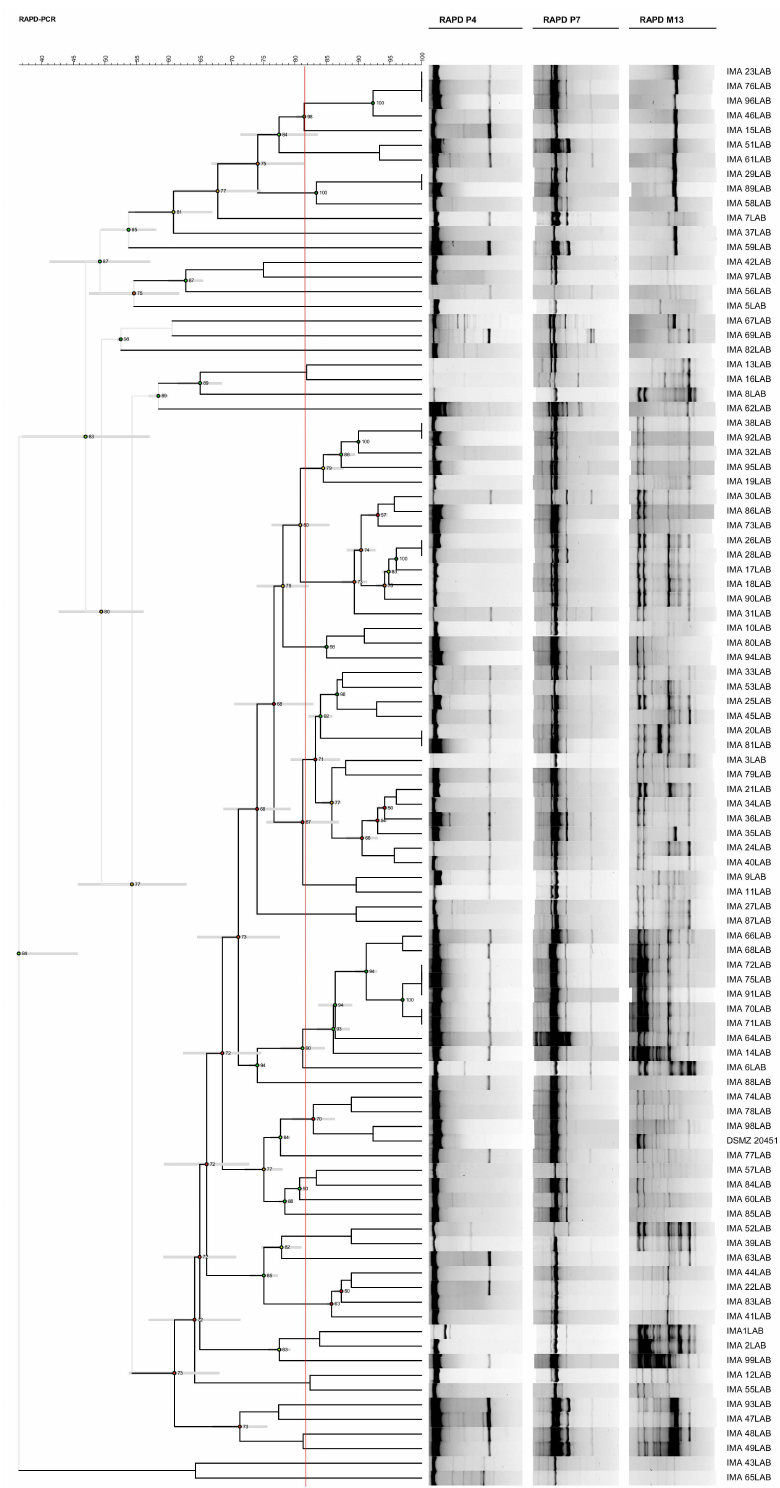
Figure 2. Dendrogram obtained from UPGMA analysis, using Dice’s coe ffi cient, based on P4, P7 and M13 random amplified polymorphic DNA (RAPD) profiles, of the 96 L. sanfranciscensis isolates characterizing PDO Tuscan bread sourdough and one reference strain. The red line indicates the similarity value (81.47%) for separation of biotypes. Standard deviation is shown at each node by a grey bar. Cophenetic correlation is shown at each branch by numbers and coloured dots, ranging between green-yellow-orange-red, according to decreasing